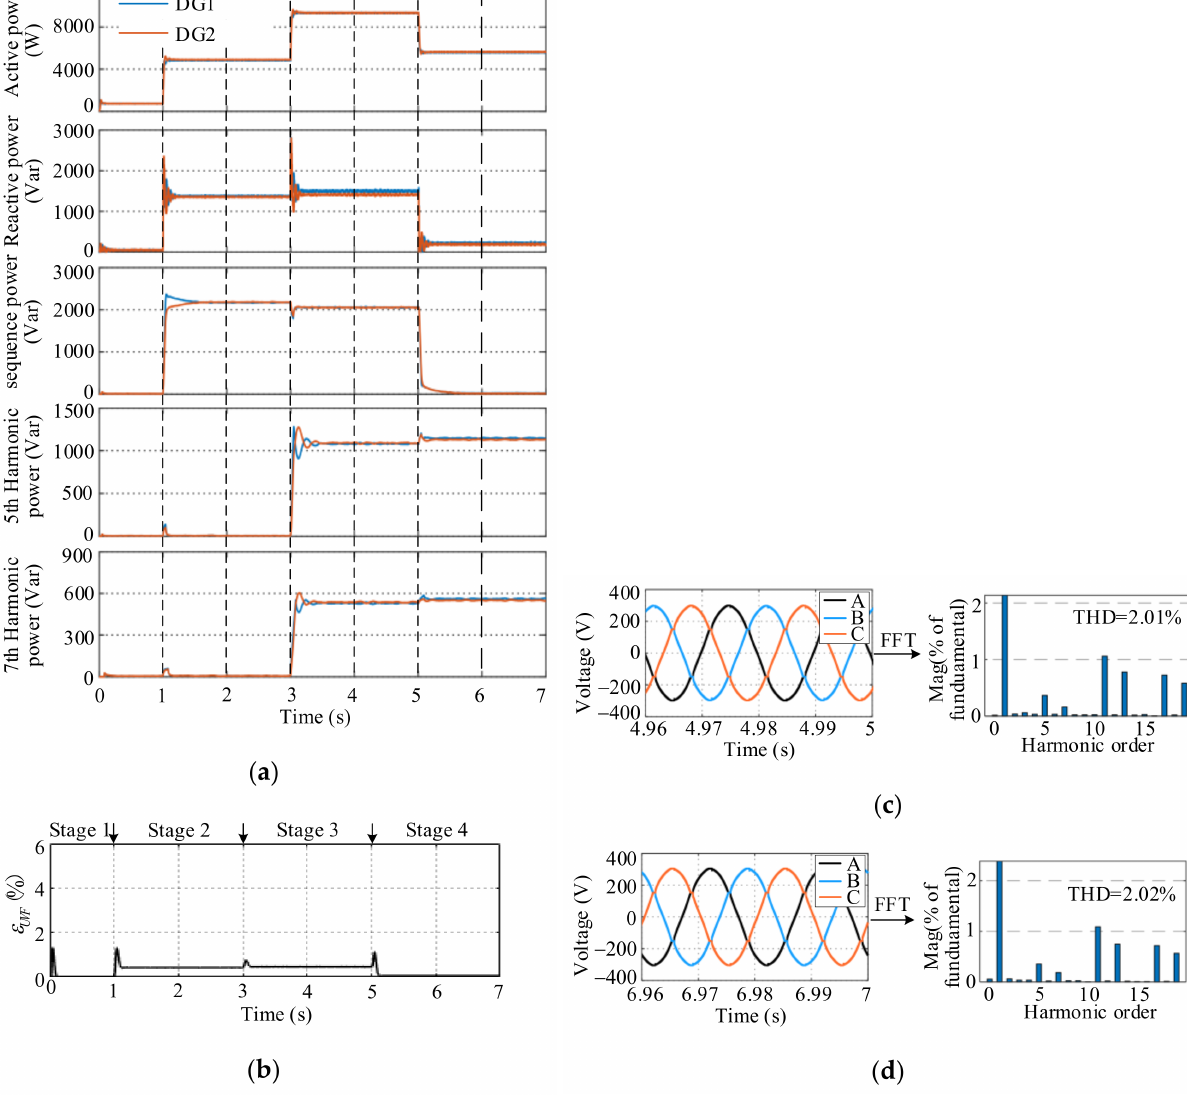
Figure 9. The proposed control strategy: ( a ) power-sharing performance; ( b ) PCC three-phase voltage unbalance ε UVF ; ( c ) PCC voltage and A-phase voltage FFT analysis in stage 3; ( d ) PCC voltage and A-phase voltage FFT analysis in stage